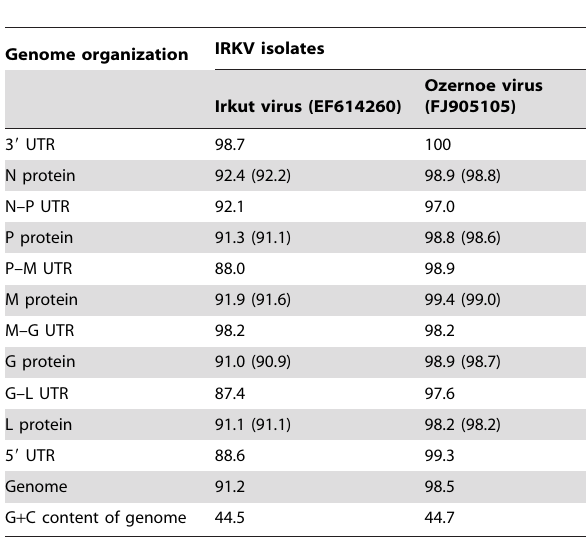
Table 1. Comparison of nucleotide and amino acid identity (%) between IRKV-THChina12 and other IRKV isolates.